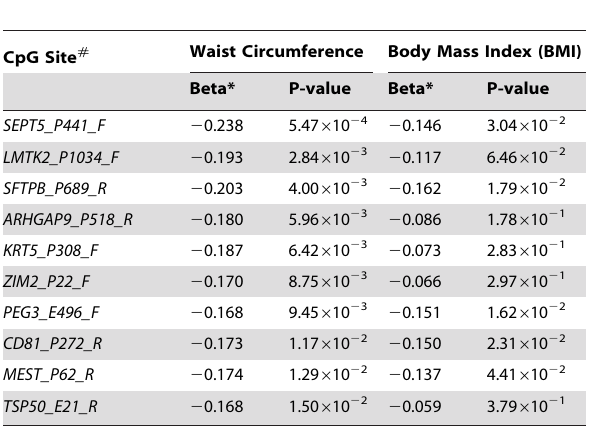
Table 3. Most highly significant associations between DNA methylation and obesity